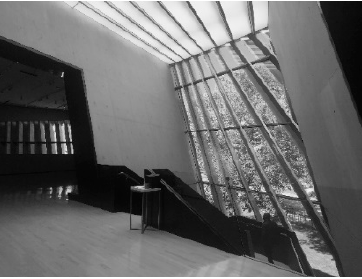
Figure 10. A view of a slim window giving a sense of orientation at UMMA. 4.1.5. Simulation of Events Consistent with literature, simulating events from the past through sound or narra- tion was also found to have a powerful impact on emotions. For example, seeing handprints on a wall at the Tate Museum triggered emotions of engagement and surprise as the participants recalled seeing the exhibit during an in-person visit prior to this re- search. Additionally, the same types of emotion were also triggered when viewing the lighting effect that represented radiation at the Chernobyl Museum. Since Chernobyl was a well-known event, simulating the incident through means like architectural lighting was successful in capturing one’s emotions.